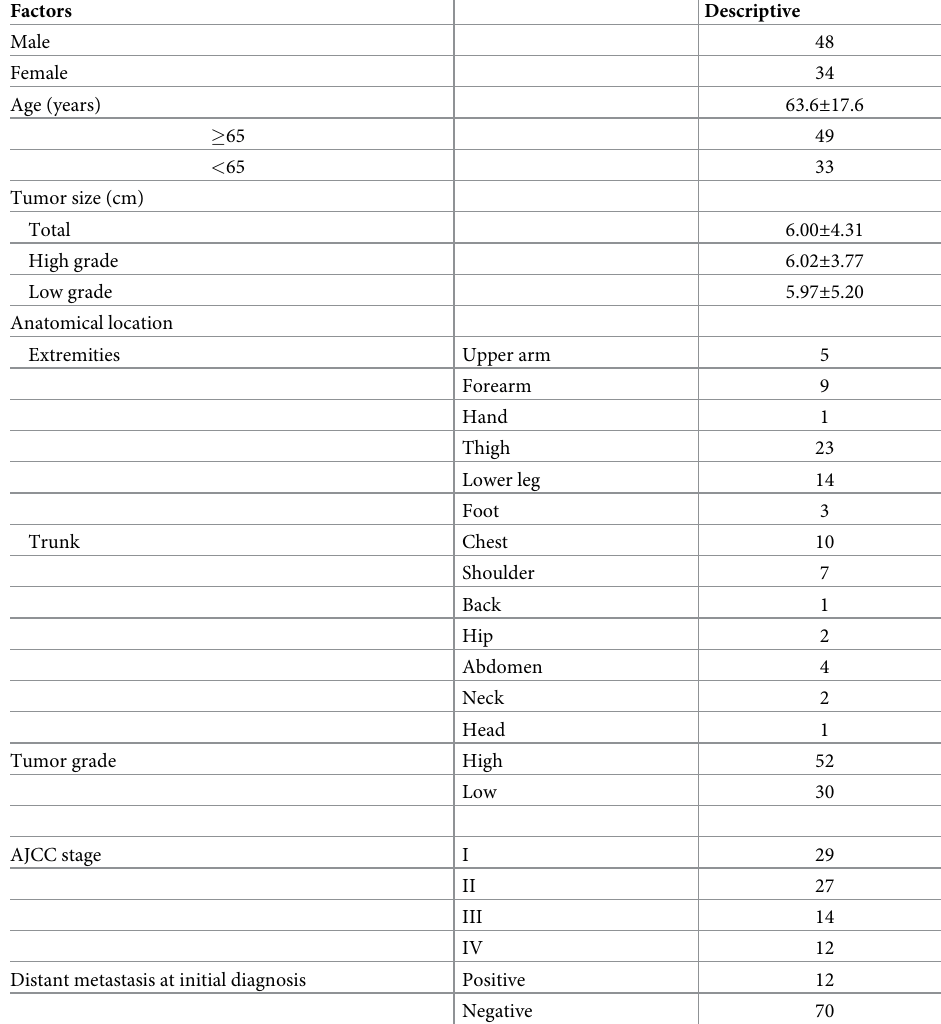
Table 1. Descriptive statistics regarding patients’ demographic